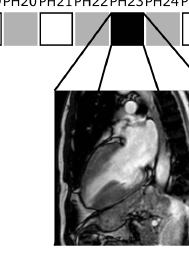
Figure 3. Long-axis CMR scan has three view: 2-chamber, 4-chamber, and 3-chamber views. For each view, 25 images are produced. The images are created from the same slice of the heart, but at different time points of the cardiac cycle. To create a fixed-size input, we picked an image from every second phase; see the gray boxes. Overall, this results in 12 images for each view (LA2, LA4, LA3).